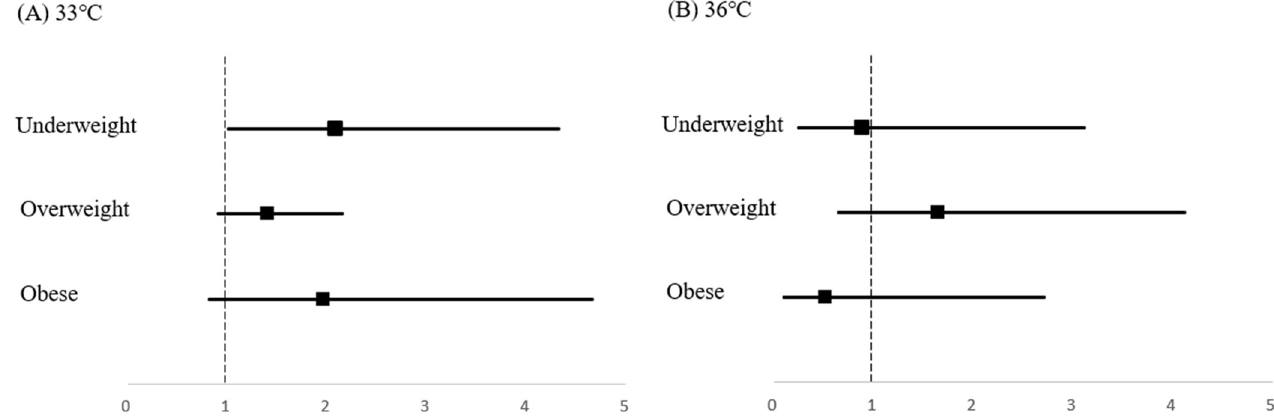
Fig 2. Forest plots of the odds ratios among the BMI groups according to the target temperature. (A) The odds ratio of 33˚C targeted temperature management (B) The odds ratio of 36˚C targeted temperature management.